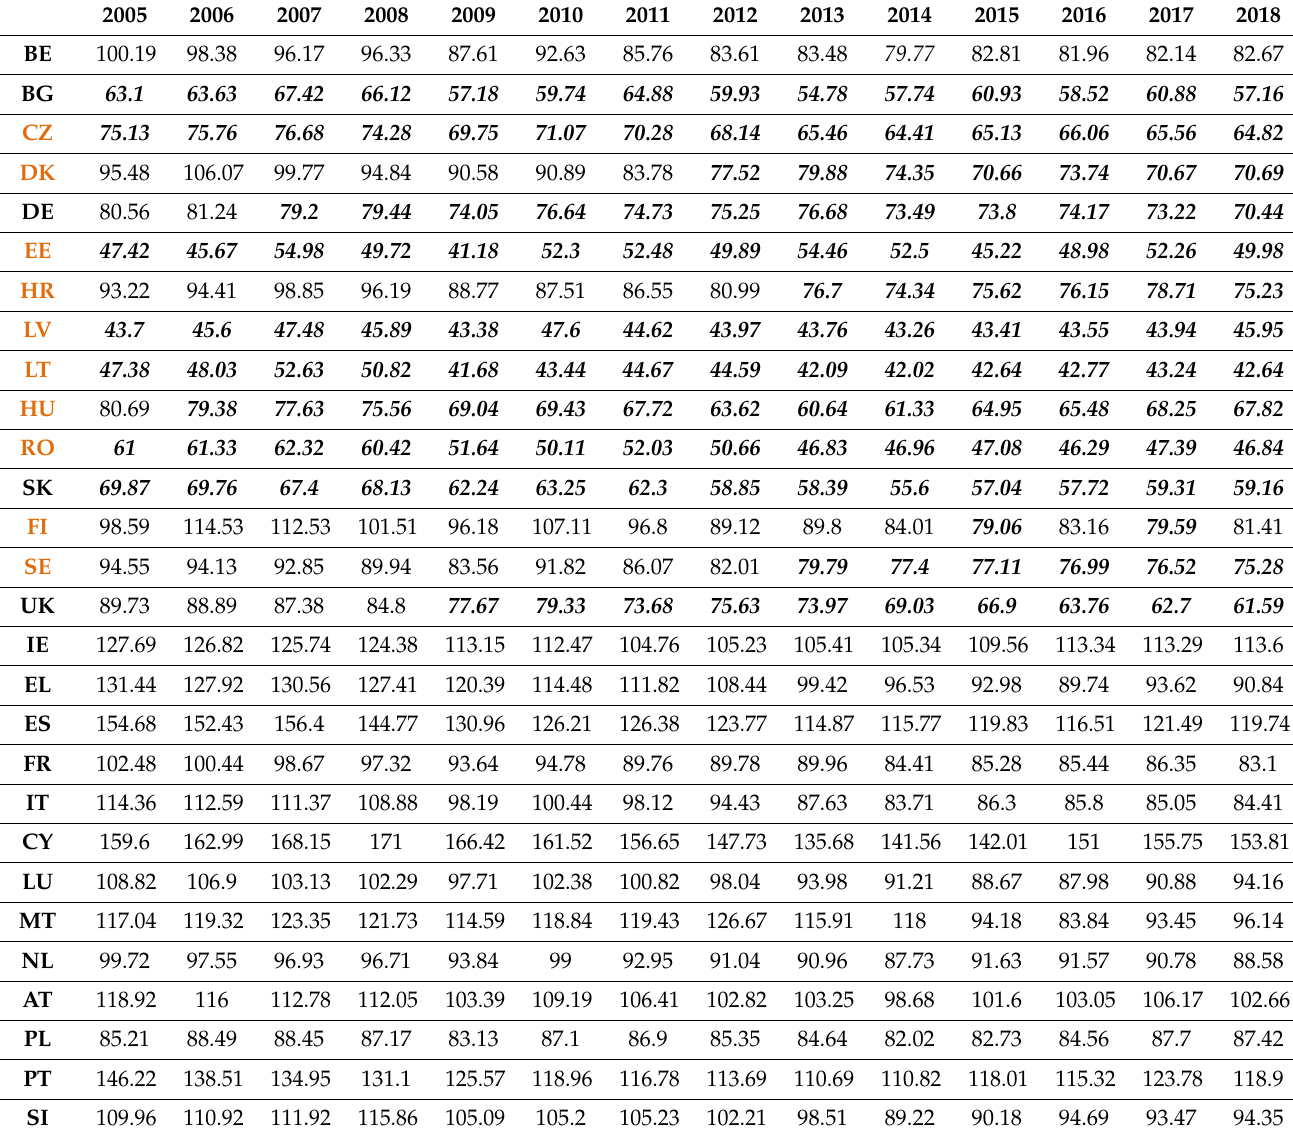
Table 2. Greenhouse gas emissions, base year